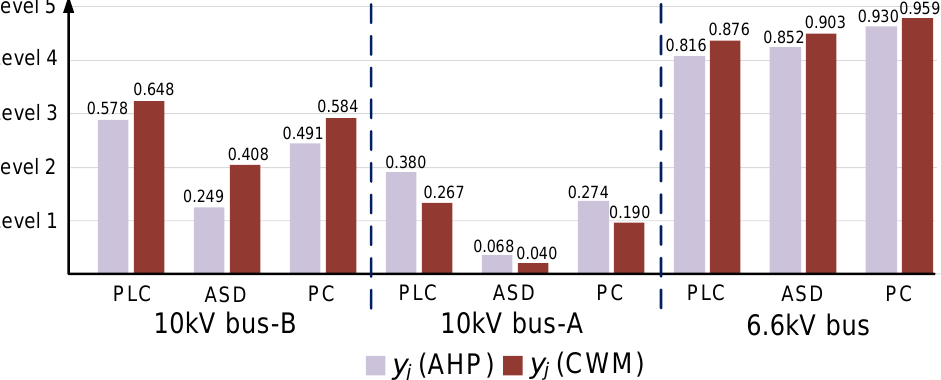
Figure 7. Voltage sag severity level of TPSF.